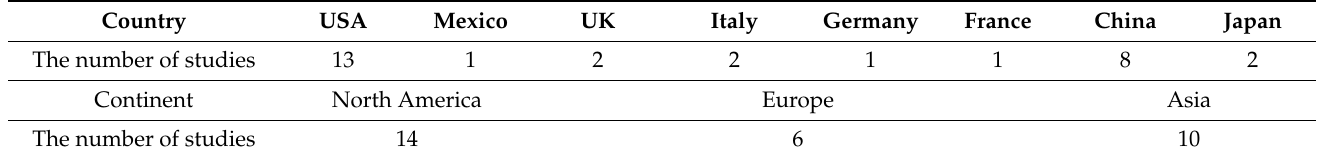
Table 4. The geographical distribution by location (country and continent) in the Included Study .